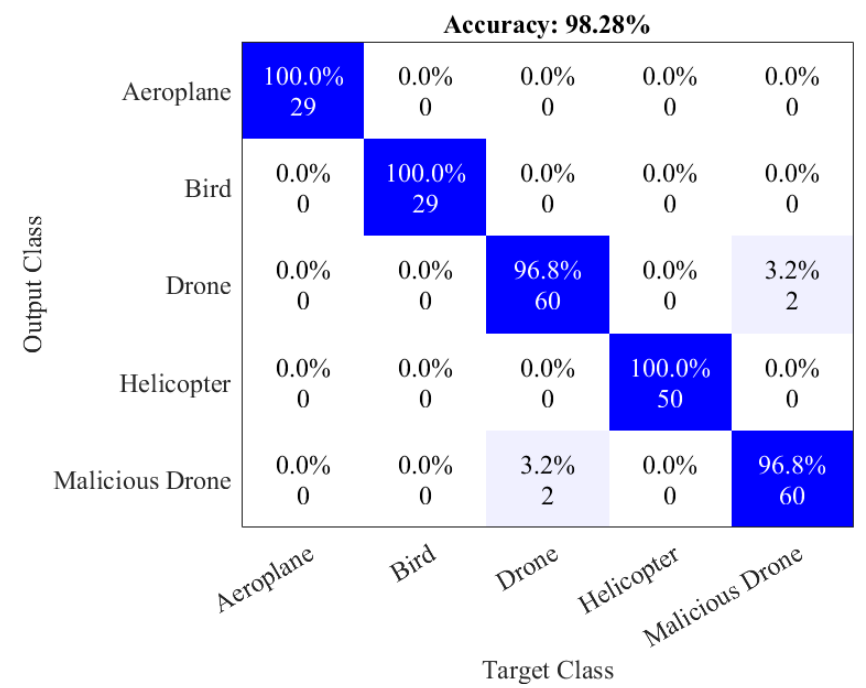
Figure 5. Confusion matrix of the ViT classifier.